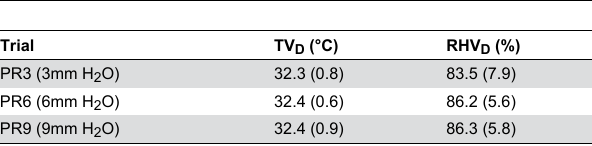
Table 2. Prototype respirator deadspace mean (standard deviation) temperature and relative humidity levels over one hour.